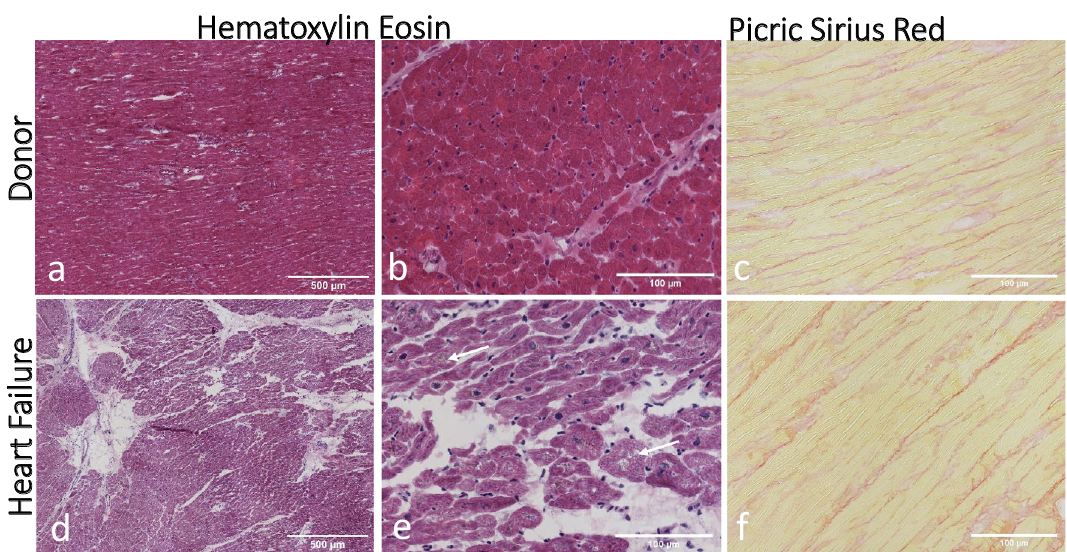
Figure 1. Histology of the left ventricular myocardium. ( a, b ) Hematoxylin–Eosin staining of tissue from a representative organ donor displays the histology of a normal myocardium. (c) Picric Sirius red staining shows the network of collagen fibers in red between cardiomyocytes. (d, e) A representative image of tissue from the heart failure group displaying excessive fibroses, hypertrophic cardiomyocytes and irregular nuclei (arrows). (f) Collagen fibers in red between hypertrophic